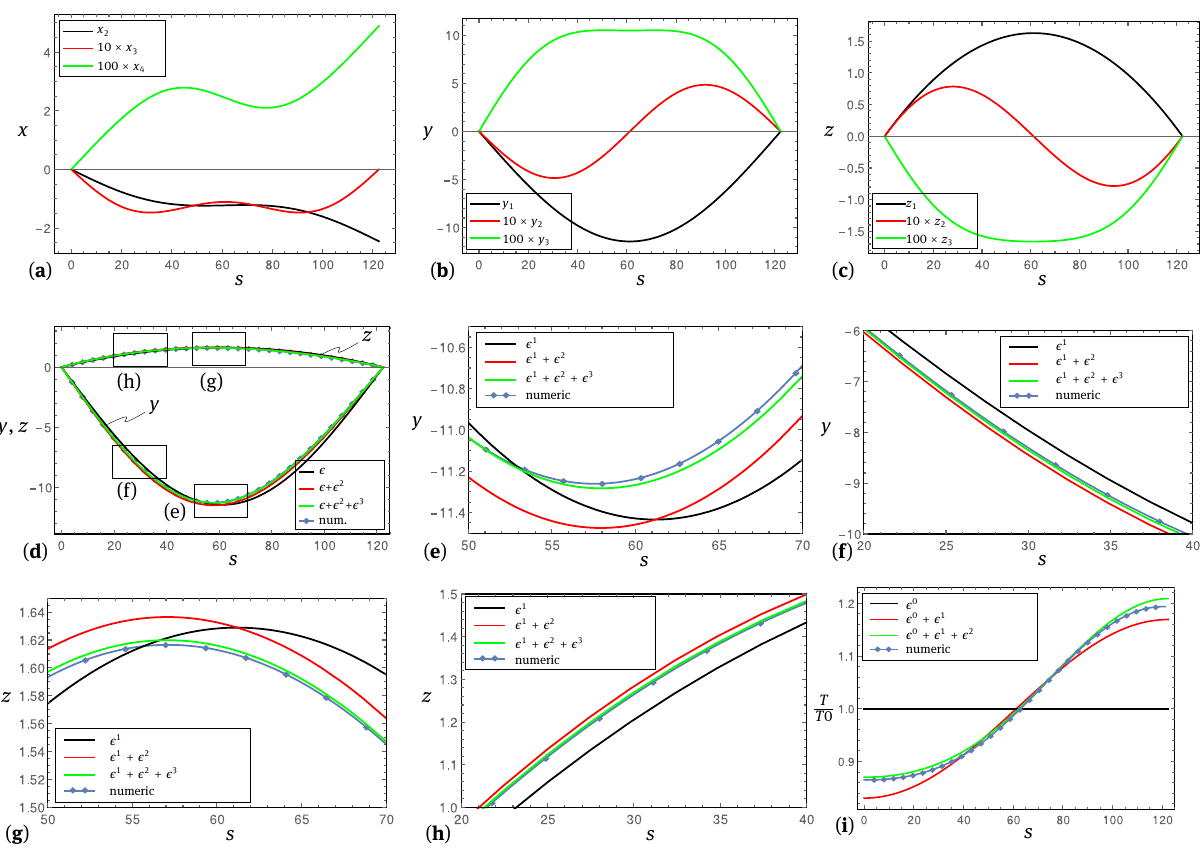
Figure 2: Case study, positive T 0 : (a) solution x ( s ) ; (b) solution y ( s ) ; (c) solution z ( s ) ; (d) reconstituted y and z , complete view and zoom windows for subfigures (e), (f), (g), (h); (e) reconstituted y close to the mid-span; (f) reconstituted y close to quarter-span; (g) reconstituted z close to the mid-span; (h) reconstituted z close to quarter-span; (i) force ratio T ( s )/ T 0 ; [ s , y , z ] = m